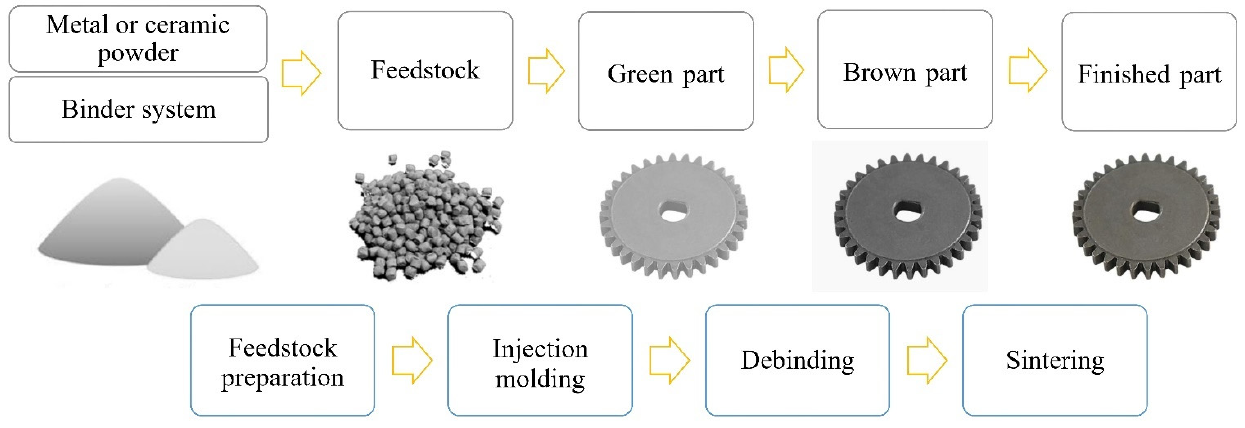
Figure 1. Material flow and processing sequence in LPIM process.